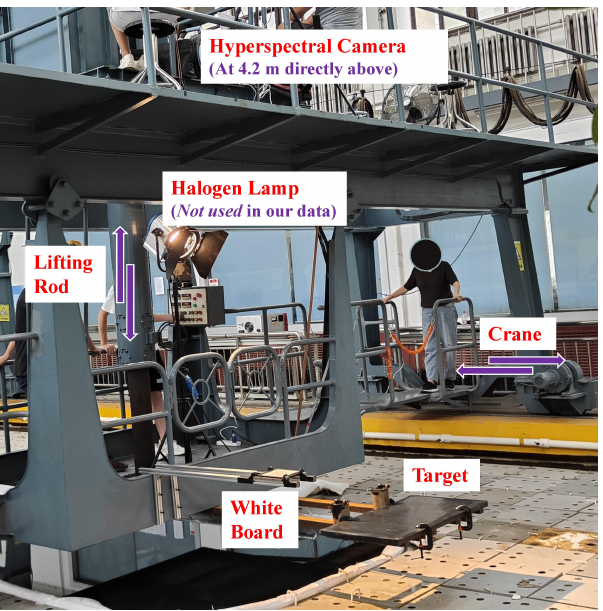
Figure 4. Anechoic pool site. The crane can be moved horizontally for the easy loading and unloading of targets. The lift rod can move up and down to place targets at different depths underwater.